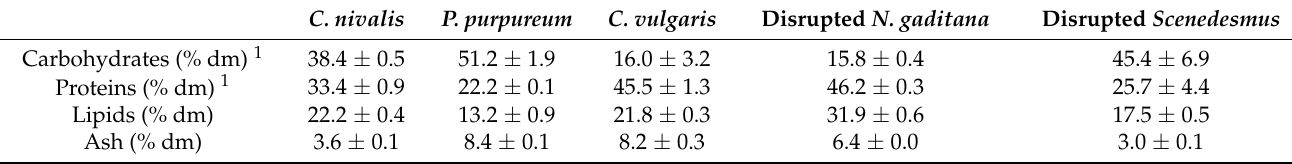
Table 1. Biochemical